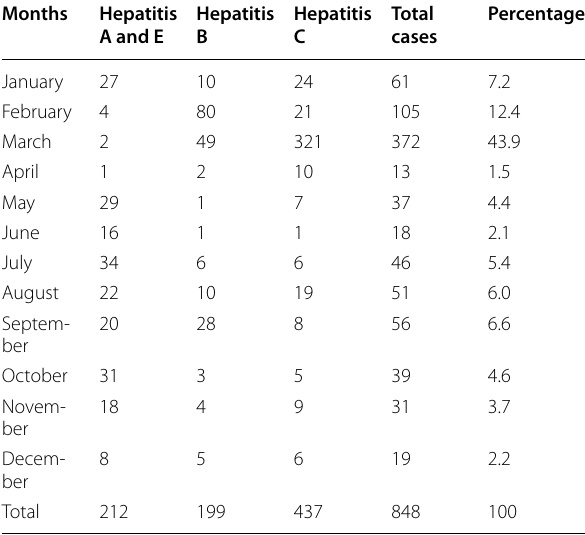
Table 1 Prevalence of different types of viral hepatitis in indoor patients in the District Dera Ismail Khan, Khyber Pakhtunkhwa,